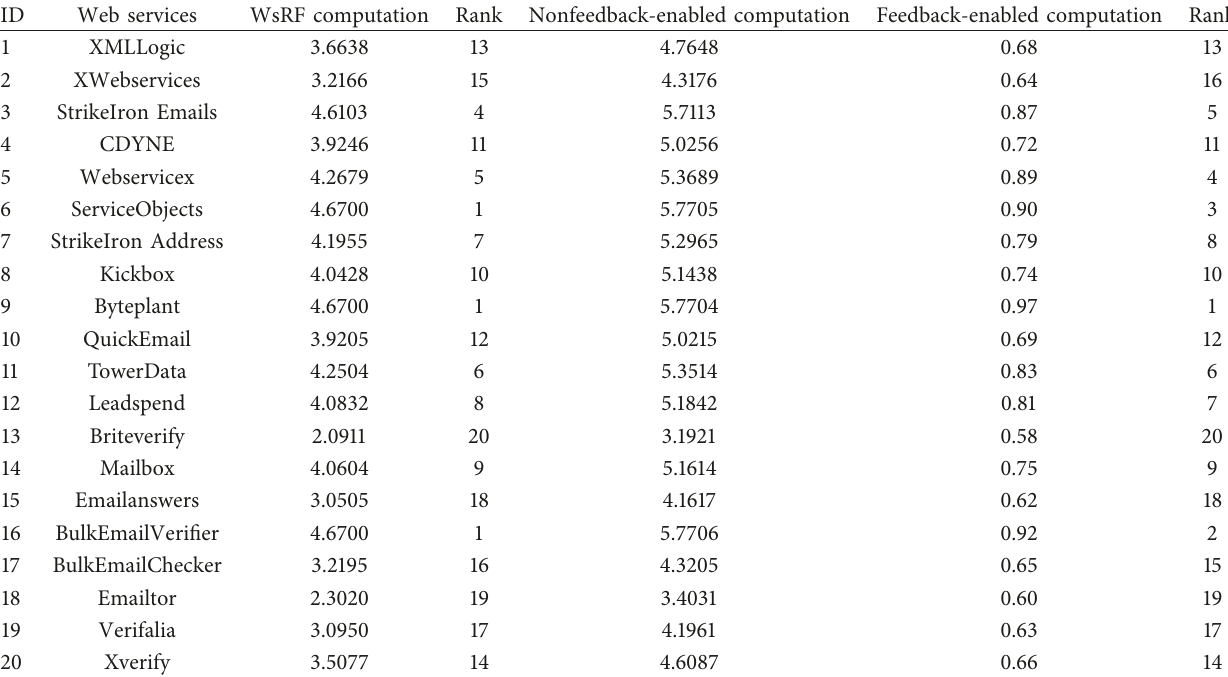
Table 5: Results of WsRF, non-FB, and FB QoS metric computation.